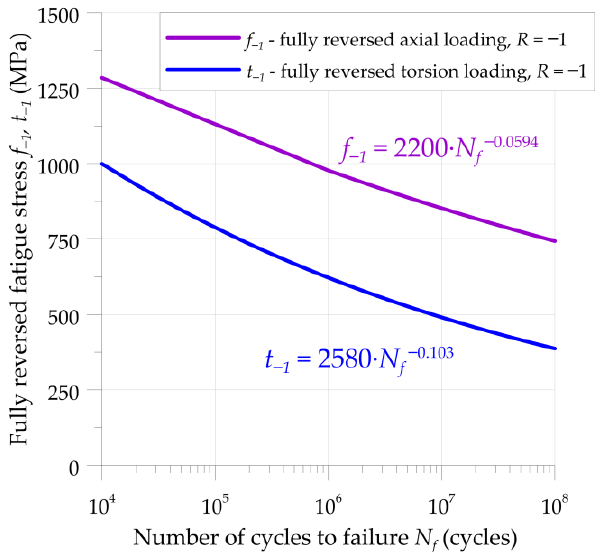
Figure 2. S-N curves for fully reversed axial f -1 and fully reversed torsion t -1 fatigue loadings, AISI 52100 bearing steel.